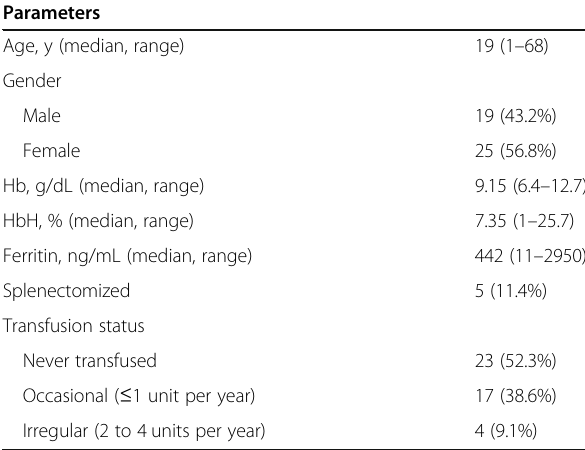
Table 1 Demographic and clinical characteristics of